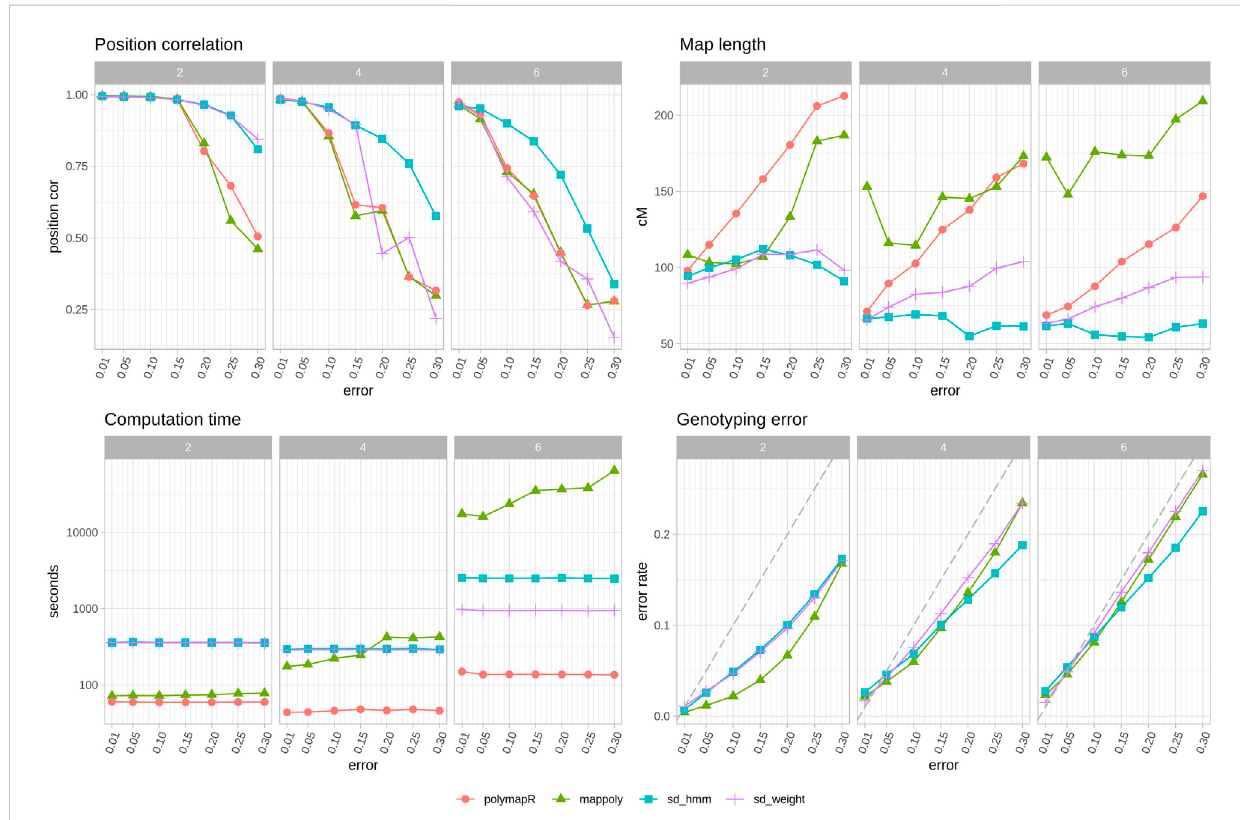
FIGURE 3 Software comparison with other tools. Average observations of 10 populations per ploidy with simulated genotyping errors. Top left, correlation between true map position and estimated map position. Top right, map length in cM. Bottom left, time spent in seconds, note logarithmic y axis. Bottom right, genotyping error of corrected genotypes. Grey dashed line indicates the starting error rate. Note that polymapR does not produce corrected genotypes and thus is not included in this panel. Each color and shape corresponds to a different approach: red circle, polymapR, green triangle MAPpoly, blue square (sd hmm) SD with HMM approach, purple cross (s _weight) SD with weighted average